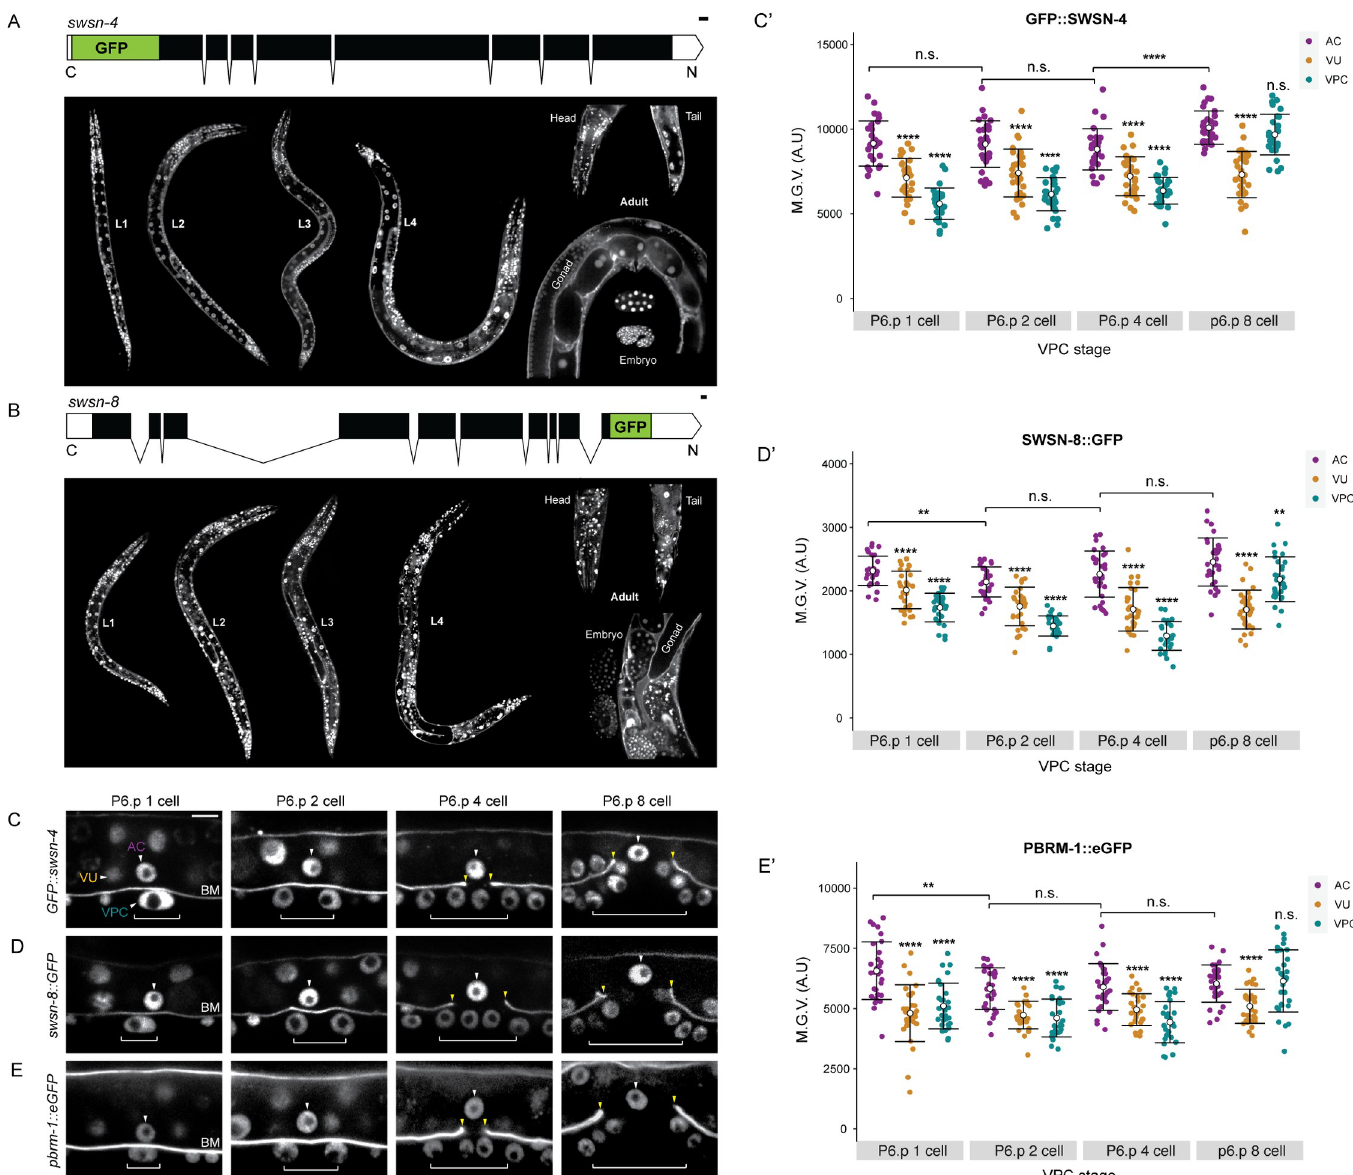
Fig 3. SWI/SNF fluorescent knock-ins express in the AC pre-, during, and post-invasion. Schematics (from http://wormweb.org/exonintron) depicting GFP insertion into the endogenous N and C termini of swsn-4 ( A , top) and swsn-8 ( B , top), respectively. Scale bar, 100bp. ( A-B , bottom) Fluorescent micrographs depicting protein expression of each SWI/SNF subunit and BM ( laminin :: GFP ) in all larval stages (L1-L4), adult, and embryos. Images scaled for clarity. Fluorescent micrographs depicting expression of GFP::SWSN-4 (C), SWSN-8::GFP (D) , and PBRM-1::eGFP (D) in the AC, VU, and VPCs from the P6.p 1-cell to the P6.p 8-cell stages of development. White arrowheads indicate AC, white brackets indicate 1˚ VPC stage. Scale bar, 5 μ m (C’-E’) Quantification of endogenous GFP expression of SWI/SNF subunit in the AC, VU, and VPC over time. Statistical comparisons were made for the expression of each SWI/SNF subunit in the AC over time (asterisks or n.s. above black brackets) or between the expression of each subunit in the AC relative to the expression of the same subunit in the neighboring VPCs or VUs at the same time (asterisks or n.s. below black brackets) using Student’s t -test (n � 30 for each stage and subunit; p values are displayed above compared groups). n.s. not significant. subunit ( pbrm-1 :: eGFP ) from the Caenorhabditis Genetics Center (CGC). We quantified fluo- rescence protein expression of SWI/SNF core ATPase (GFP::SWSN-4), BAF (SWSN-8::GFP), and PBAF (PBRM-1::eGFP) subunits in the AC during vulval development across the L3 and early L4 stages, as defined by the division pattern of the 1˚-fated VPCs [14] (n � 28 animals per